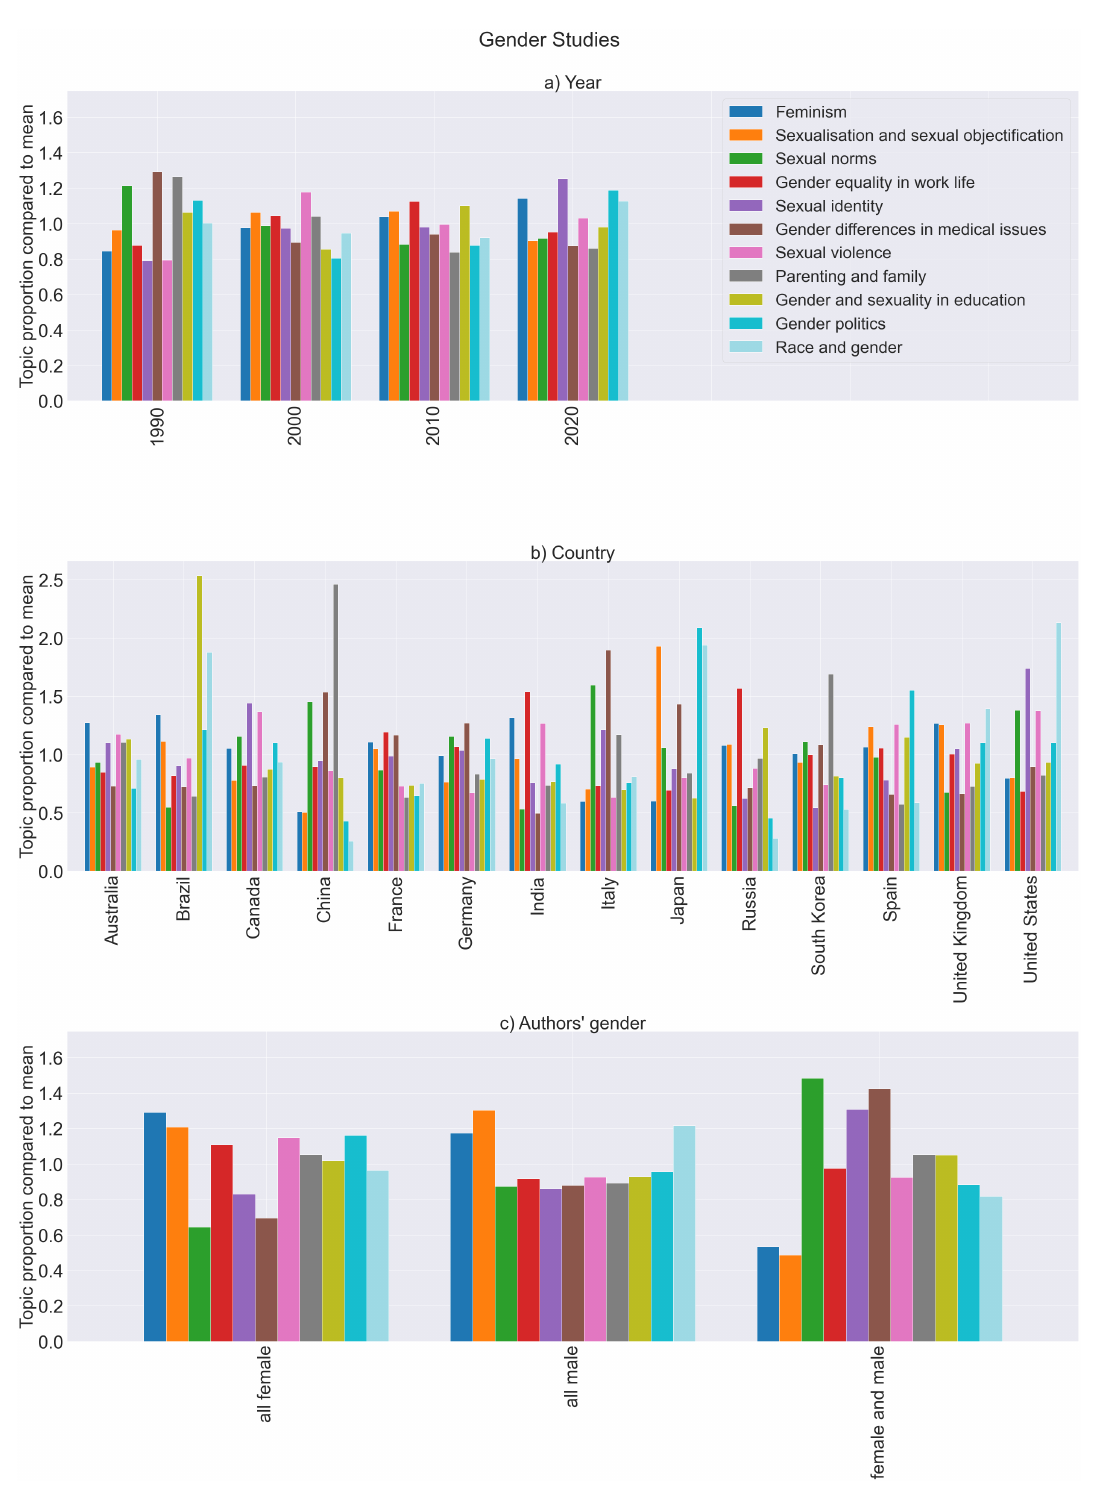
Figure 10. Topic proportion compared to mean, c κ ( ˆ D α ) , for 11 topics of the sub-area gender studies grouped by ( a ) publication year, ( b ) country, and ( c ) authors’ gender. The legend for the topics and their colour codes at the top right corner applies to all three sub